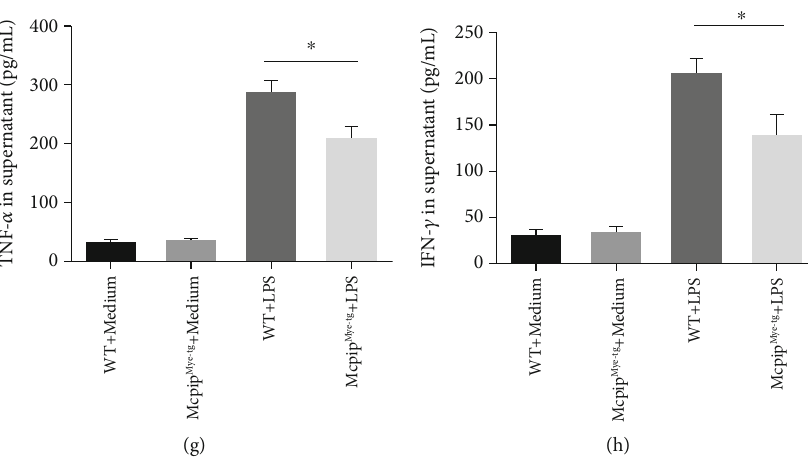
Figure 8: Overexpression of MCPIP-1 degrades the mRNA and protein levels of proin fl ammatory cytokines in neutrophils. Neutrophils ( 6 × 10 6 ) were isolated from the bone marrow of Mcpip Mye-tg ( n = 6 ) and WT ( n = 6 ) mice and stimulated with LPS (100ng/mL) in vitro for 3 hours. One part of the neutrophils ( 5 × 10 6 ) was harvested, and expression of IL-6 (a), IL-1 β (b), TNF- α (c), and IFN- γ (d) was analyzed by quantitative RT-PCR and normalized to GAPDH. The rest of the cells ( 1 × 10 6 ) was collected and incubated in the replenished medium for another 24 hours. Supernatants were then harvested, and protein levels of IL-6 (e), IL-1 β (f), TNF- α (g), and IFN- γ (h) were measured by ELISA. ∗ P < 0 : 05 , ∗∗ P < 0 : 01 , ∗∗∗ P < 0 : 001 , and ∗∗∗∗ P < 0 : 0001 .